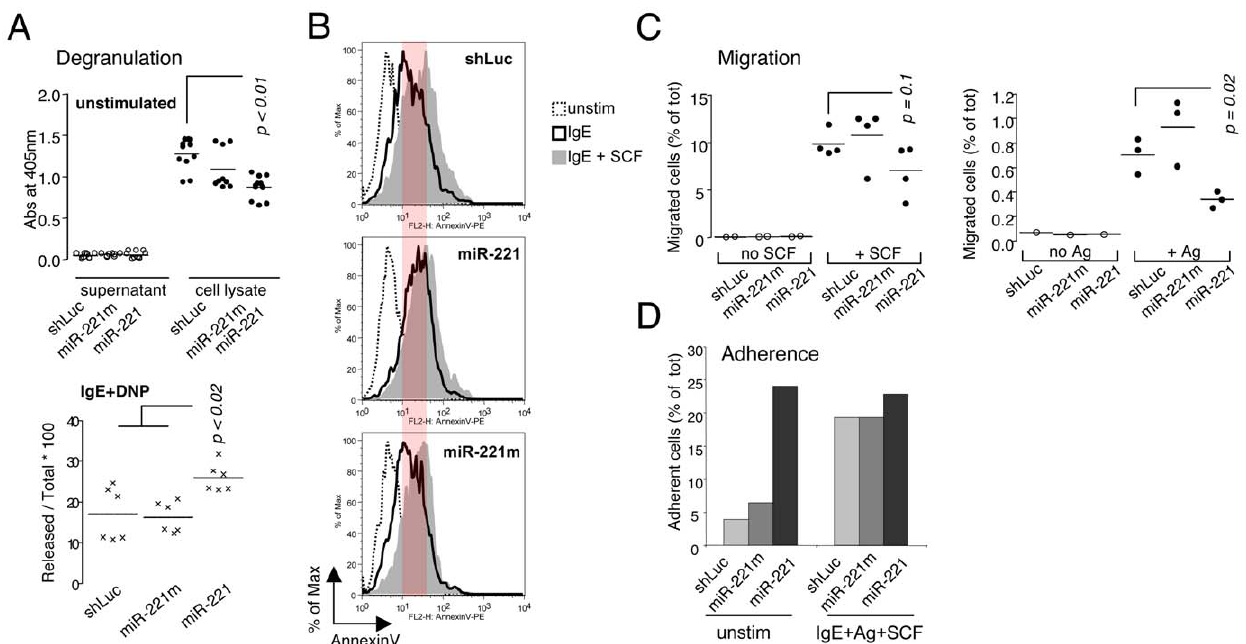
Figure 2. Degranulation, migration and adherence of cells overexpressing miR-221. A ) Transduced BMMCs were either left unstimulated ( upper panel ; n=5 experiments, each performed in triplicate) or were stimulated with IgE anti-DNP and DNP-HSA for 1h ( lower panel ; n=2 experiments, each performed in triplicate) prior measurement of b -N-acetylhexosaminidase release to assess degranulation. B ) Transduced BMMCs were either left unstimulated or were stimulated for 30min with IgE-antigen complexes alone or in combination with 20ng/mL of SCF. Cells were then stained with annexin V-PE to assess the extent of degranulation (representative of 2 independent experiments). The red shading in the figure indicates the difference between IgE versus IgE + SCF stimulation in control cell, which is reduced in miR-221-expressing cells). C ) Right panel : BMMCs transduced with indicated vectors were seeded in the upper well of a transwell chamber and then allowed to migrate towards the lower chamber containing no chemoattractant (empty circles) or SCF (black circles). Each circle represents one independent experiment. Left panel : same as above, except that cells were sensitized with anti-DNP IgE overnight, and allowed to migrate towards the antigen (DNP-HSA). D ) BMMCs transduced with the indicated vectors were seeded on a monolayer of 3T3 cells, and were either left resting or were stimulated for 8h with IgE-antigen complexes and SCF. Cells were then detached by treatment with 10mM EDTA, and the percentage of adherent cells versus total was assessed by surface staining for KIT and FACS analysis. Shown is one experiment out of at least